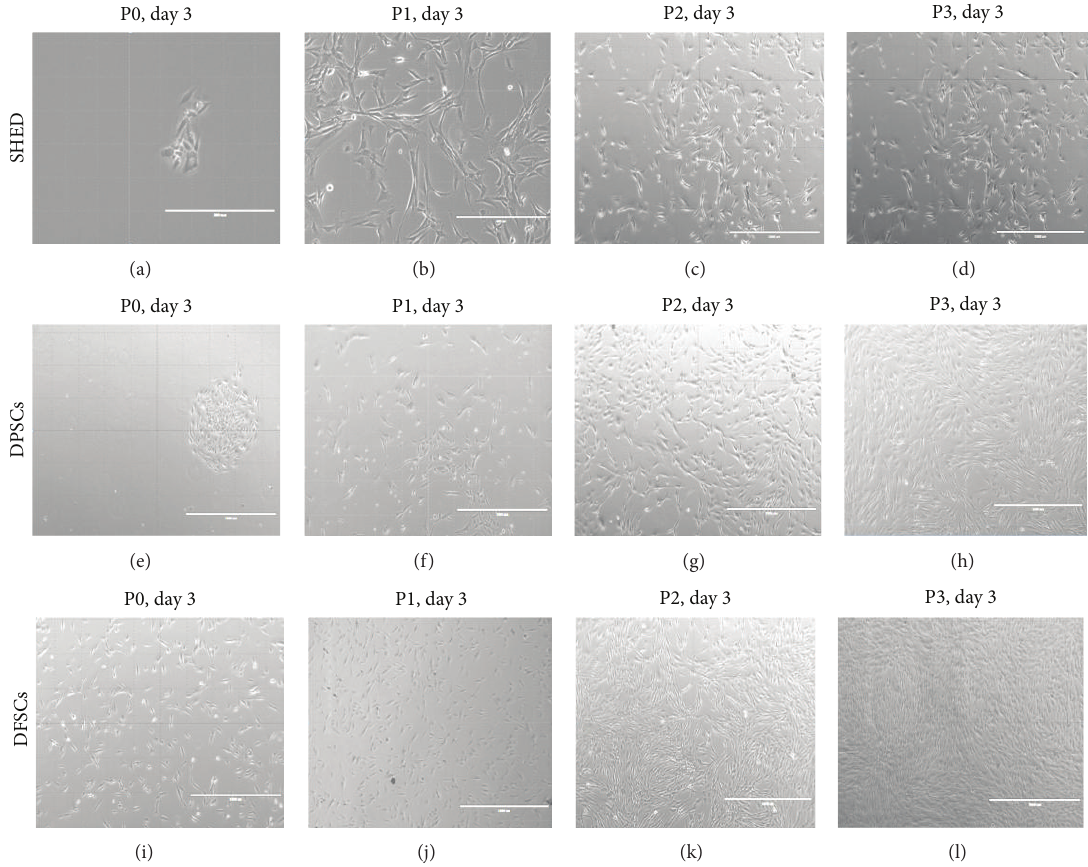
Figure 1: Morphological appearance of SHED, DPSCs, and DFSCs. Morphology of SHED, (a) P0: 3rd day, (b) P1: 3rd day, (c) P2: 3rd day, and (d) P3: 3rd day. Original magnifications: (a and b) × 20; (c and d) × 10. Morphology of DPSCs, (e) P0: 3rd day, (f) P1: 3rd day, (g) P2: 3rd day, and (h) P3: 3rd day. Original magnifications: (e, f, g, and h) × 10. Morphology of DFSCs, (i) P0: 3rd day, (j) P1: 3rd day, (k) P2: 3rd day, and (l) P3: 3rd day. Original magnifications: (i) × 20; (j, k, and l) ×